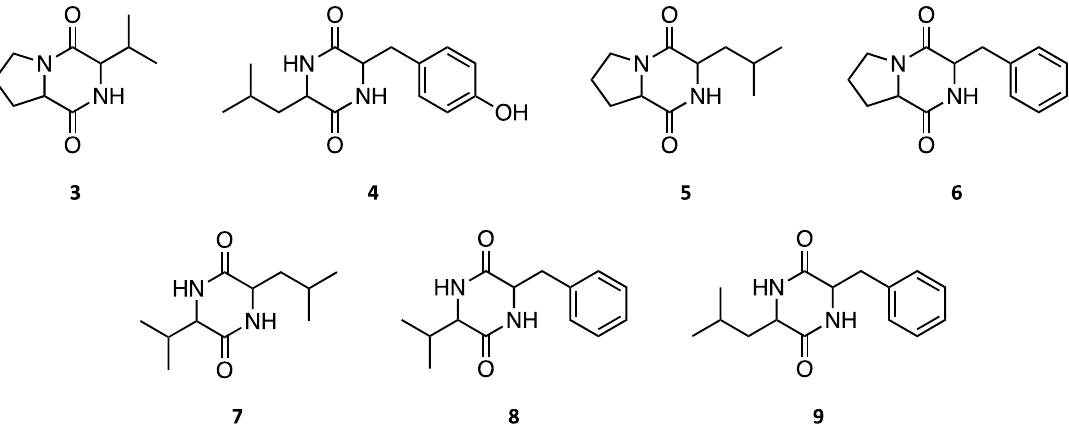
Figure 5. Minor diketopiperazines identified in the crude extract of A. dauci ; cyclo-(pro-val) ( 3 ), cyclo-(leu-tyr) ( 4 ), cyclo-(pro-leu) ( 5 ), cyclo-(pro-phe) ( 6 ), cyclo-(val-leu) ( 7 ), cyclo-(val-phe) ( 8 ), and cyclo-(leu-phe) ( 9 ).